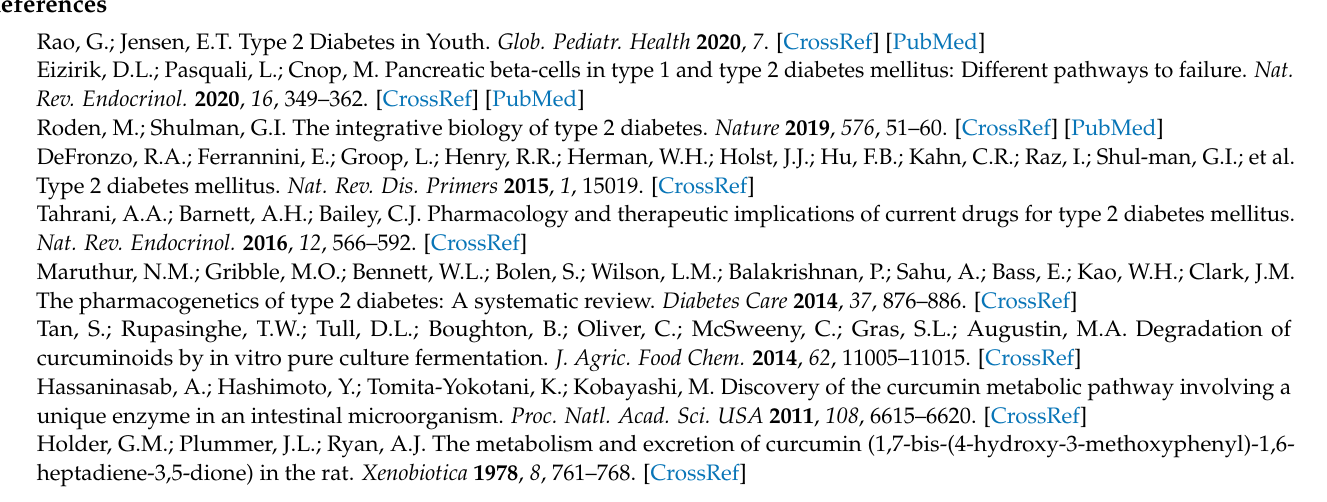
Figure S5: Upregulation of adipose UCP-1 by THC in HFD/STZ treated mice, Figure S5. THC improved AdipoR-APPL1, insulin signaling, and protein expression involved in lipid metabolism in skeletal muscle of HFD/STZ treated